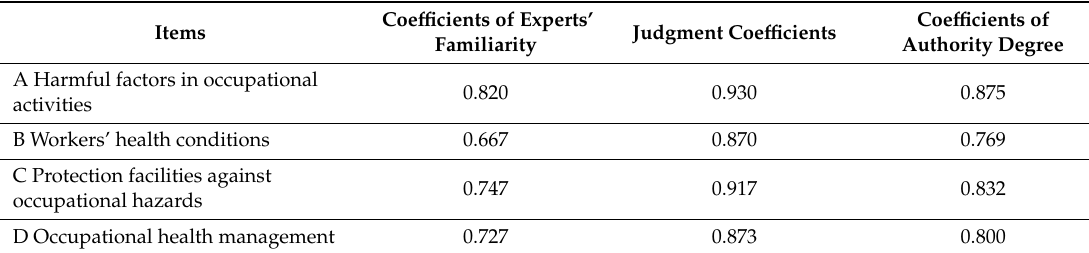
Table 2. Scores of degree of authority of expert